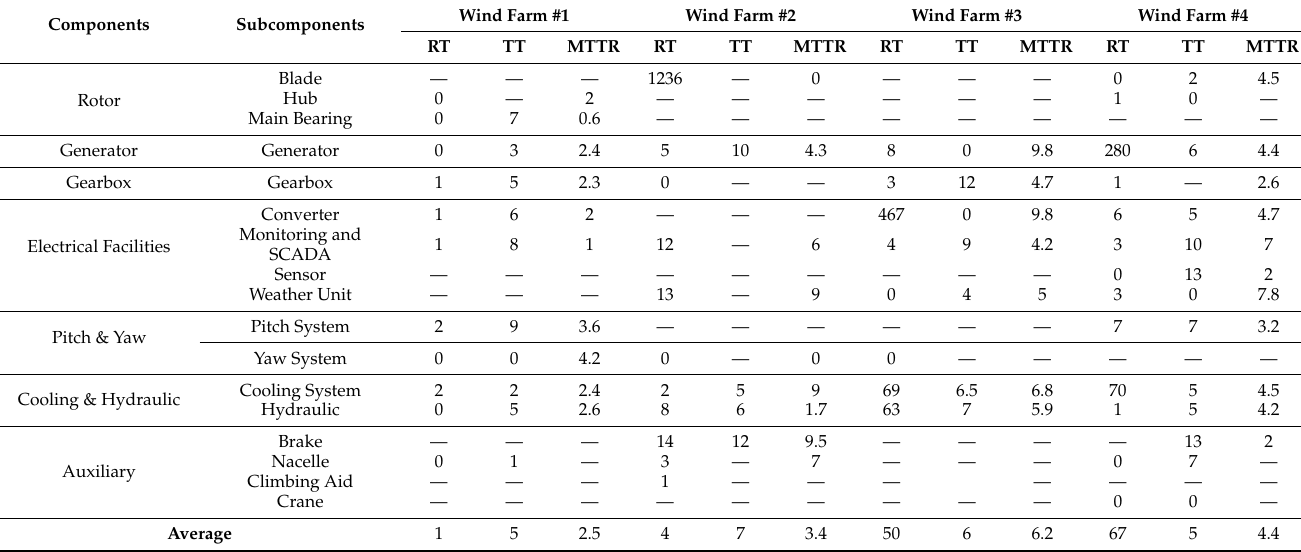
Table A3. RT, TT, and MTTR of components by wind farm/hour.